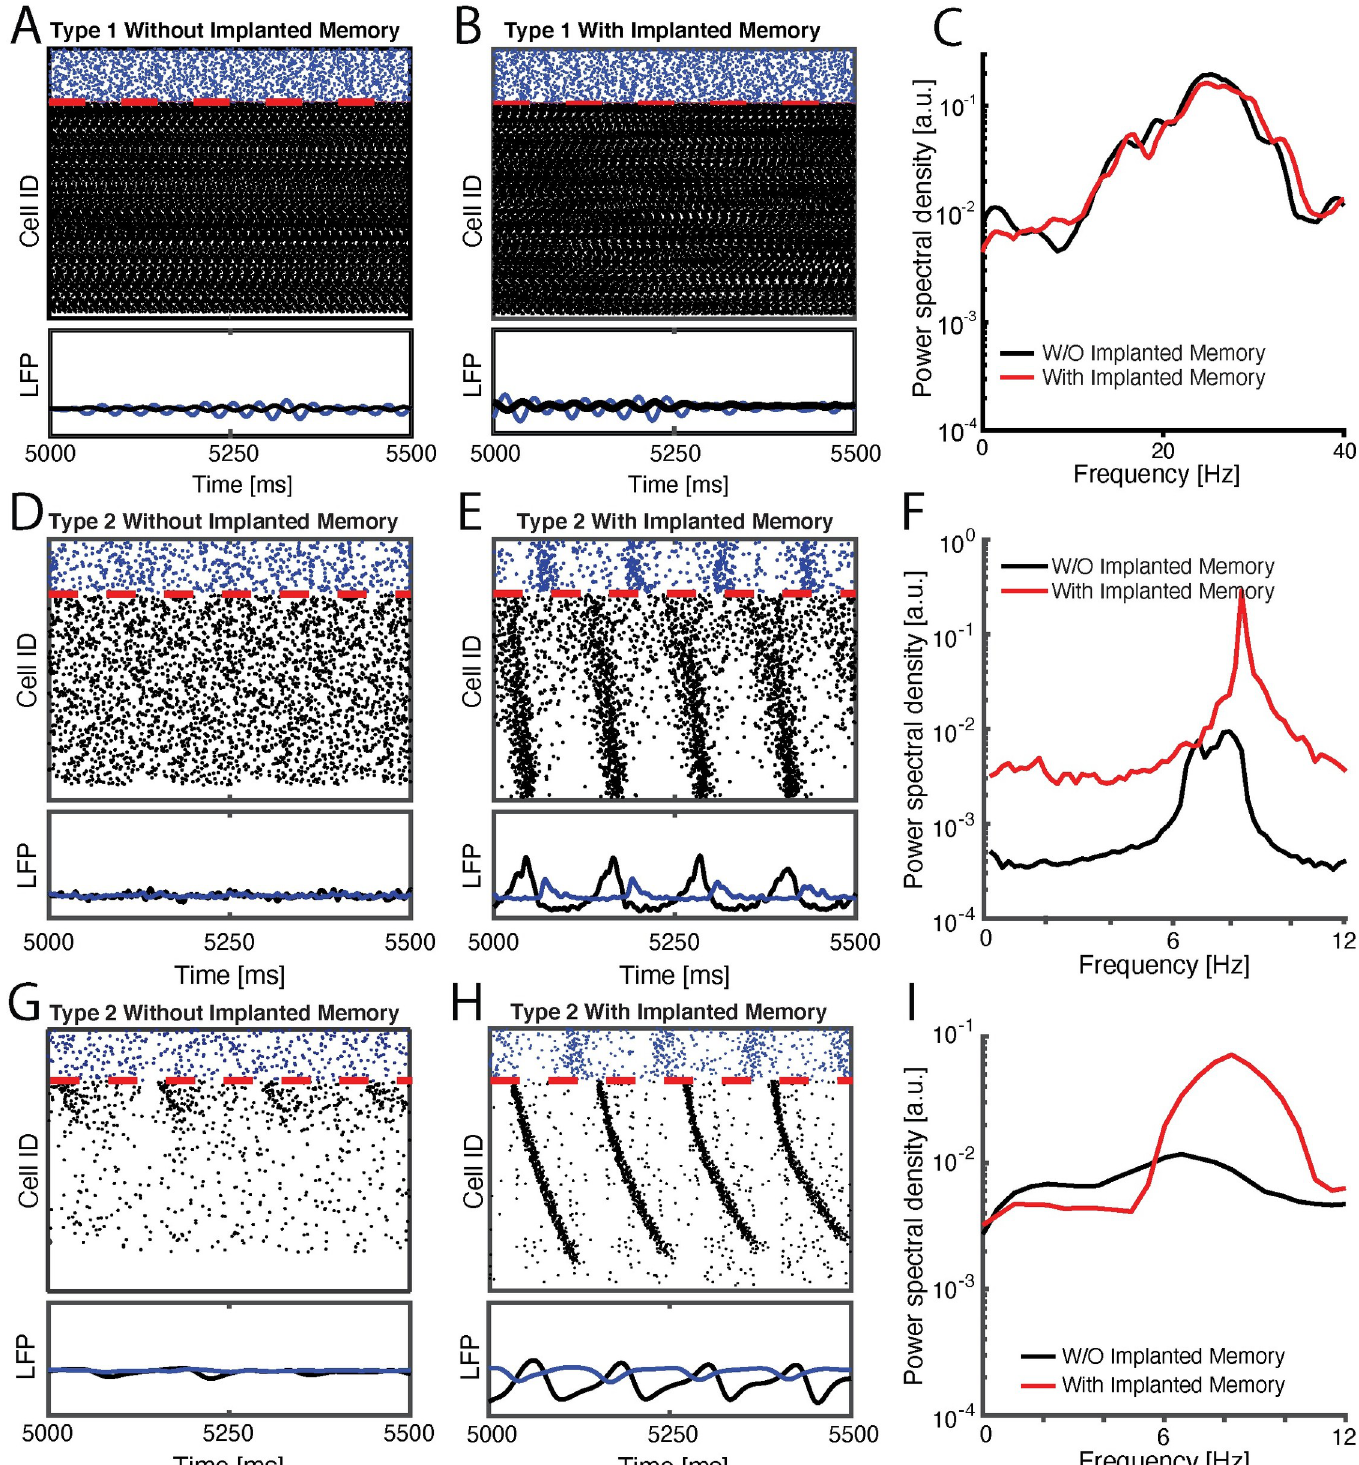
Fig 1. Type 2 model networks respond to sparse strengthening of excitatiory synapses or increasing excitatory input, through emergence of low-frequency rhythms and phase-locking. SIMULATED DATA: Raster plots (top) and cumulative signal (bottom) generated by inibitory (blue), and excitatory (black) neurons in a wake-like (high-ACh) state before (A) and after (B) initial memory storage. C) Fourier transform of the wake-like excitatory network signal before (black) and after initial memory